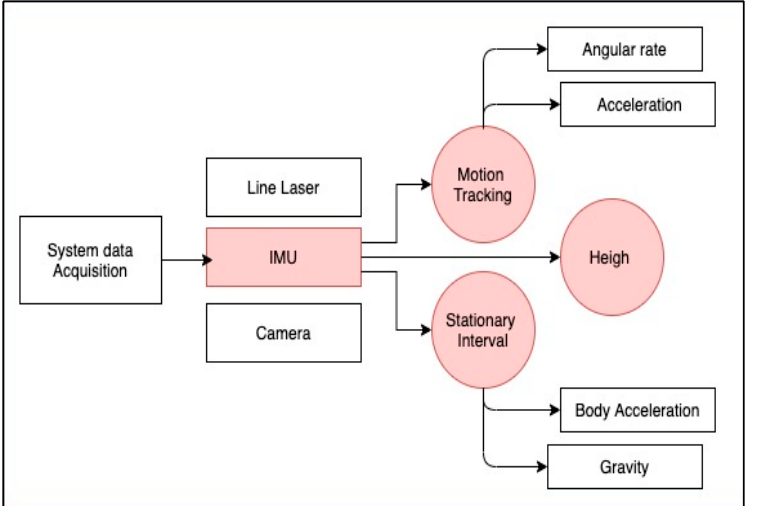
Figure 5. Adaptation diagram from the assistance system solution prototype and user’s swing motion by [94].